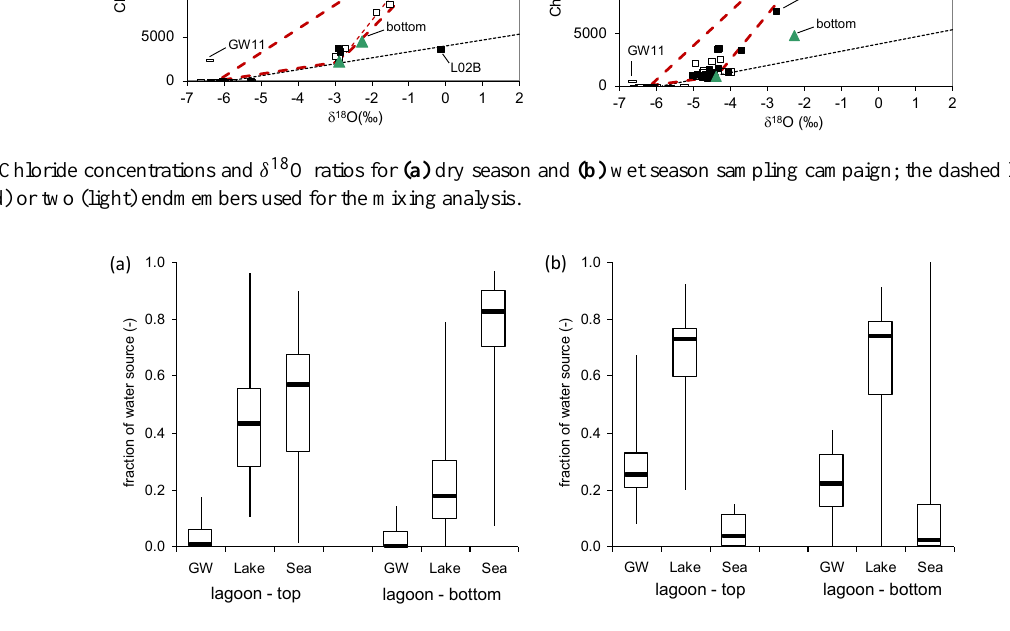
was found with distance from the shore line (Fig. 7c, d); the error bars in Fig. 7 indicate the variability of the results when using δ 18 O and Cl − or δ 18 O and salinity as signatures for the endmember mixing